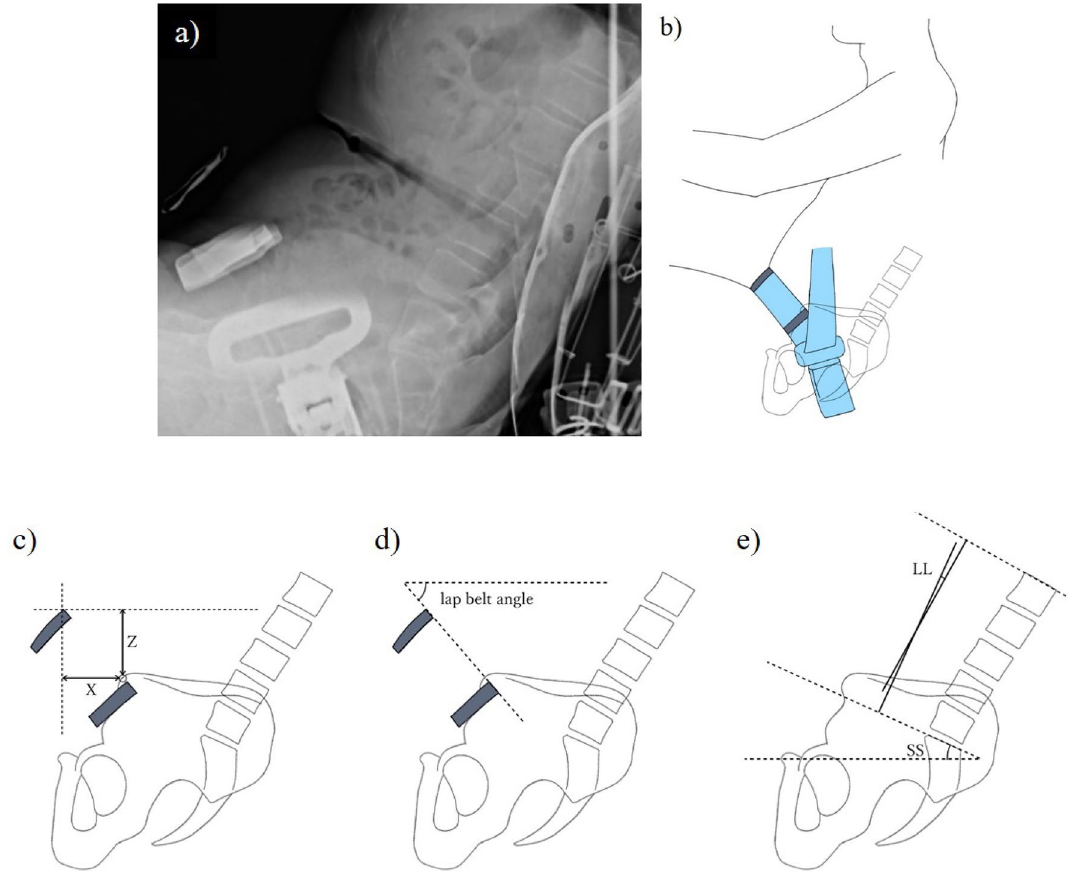
Figure 3. Seated lumbopelvic lateral radiograph ( a ) and illustration ( b ). The horizontal distance between the vertical line drawn from the ASIS and the upper edge of the midline marker was measured as the X-value, and the vertical distance between the horizontal line drawn from the ASIS and the upper edge of the midline marker was measured as the Z-value ( c ). The lap belt angle was measured as the angle between the straight line connecting the upper edge of the markers and the horizontal line ( d ). Lumbar lordosis (LL) was defined as the angle between the first lumbar superior endplate and the first sacral superior endplate, and sacral slope (SS) was defined as the angle between the first sacral superior endplate and the horizontal line, were measured for the lumbopelvic alignment ( e